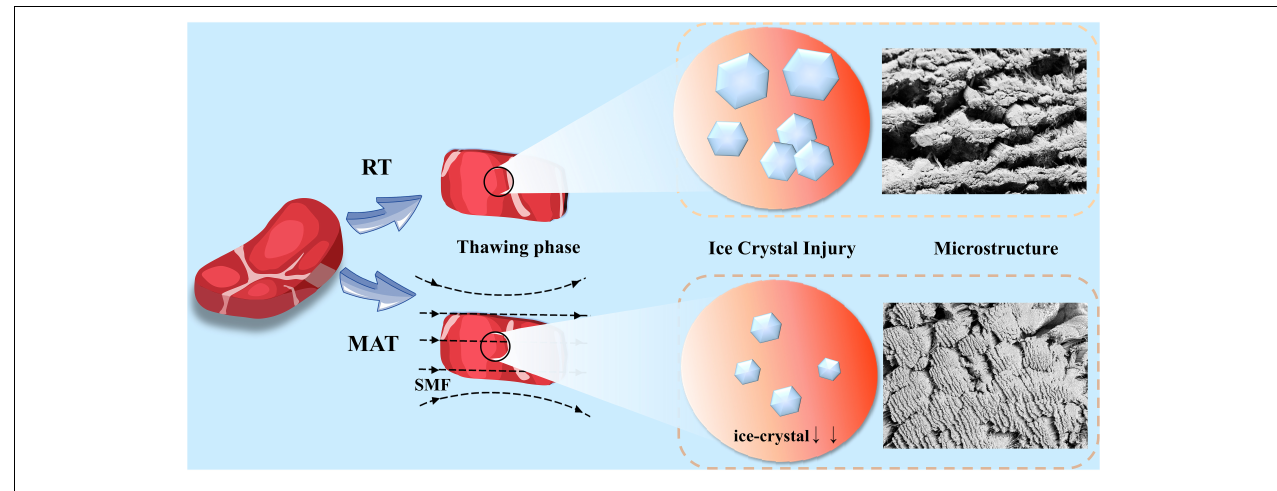
FIGURE 7 | Schematic diagram of the underlying mechanism of